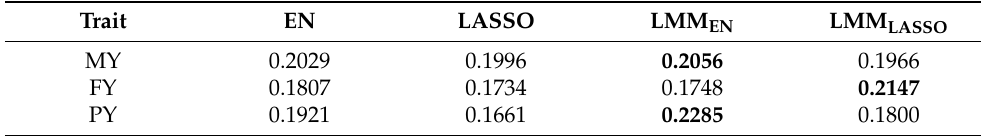
Table 2. Prediction accuracy of GS with different feature selection methods.